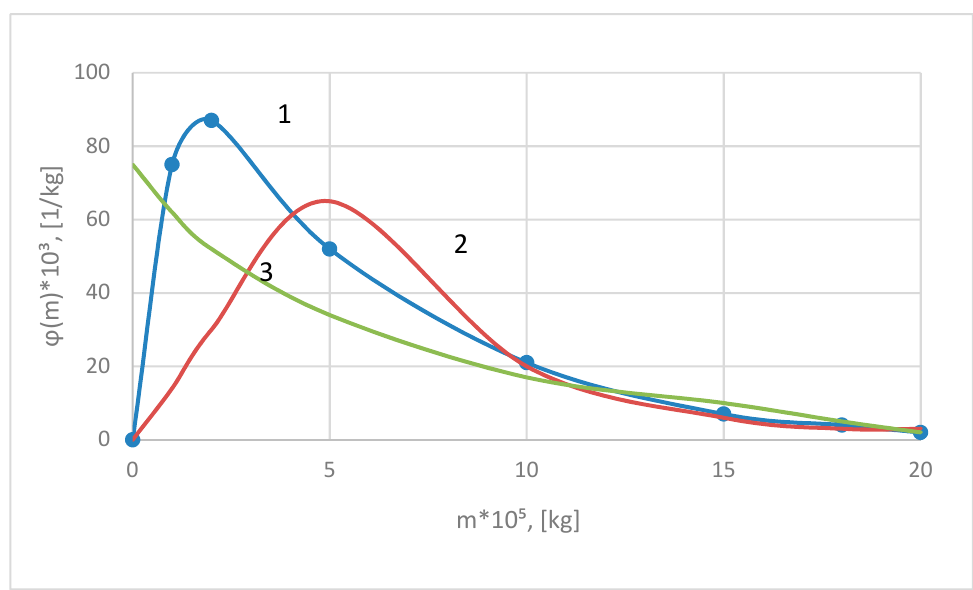
Figure 1. Differential particle mass distribution function. 1—experimental; 2—calculated at u = const ; 3—calculated at u = Am .